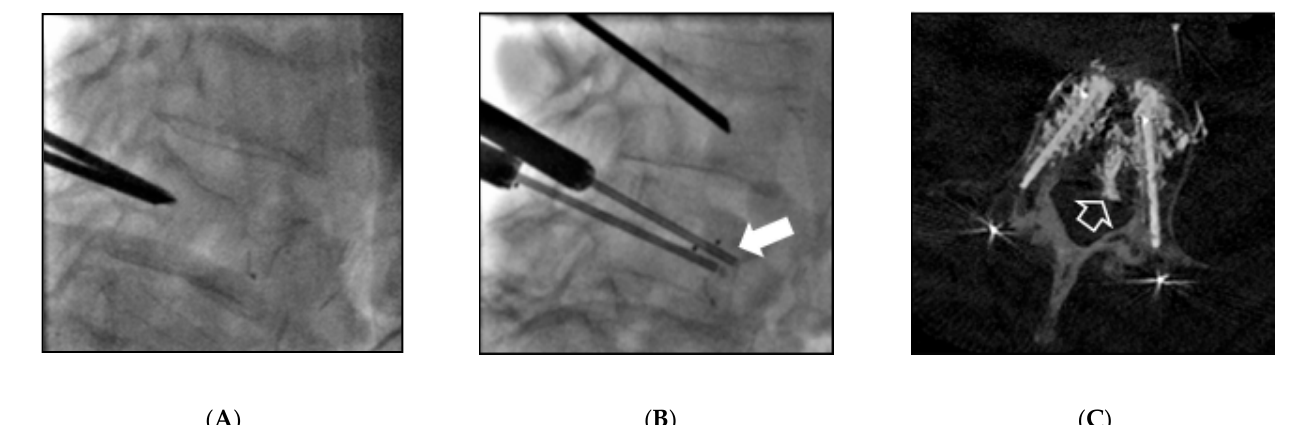
Figure 2. V-strut ® implantation in a 54-year-old woman (Patient 5) with breast carcinoma metastasis of L4. ( A ) The two devices were inserted into the vertebral body via a bilateral transpedicular approach until the desired position of 5 mm from the anterior wall, arrow. ( B ) A posterior cement leakage was observed on final cone beam computed tomography reconstruction, arrow. ( C ) Results are presented as means ± standard deviations. A matched paired analysis of visual analogue scale scores was performed to assess for changes in pain following interventions using Student’s t-test. Results were considered statistically significant when p -values < 0.05. Data analysis was performed using Stata 20.0 (StataCorp LLC, College Drive, TX, USA).